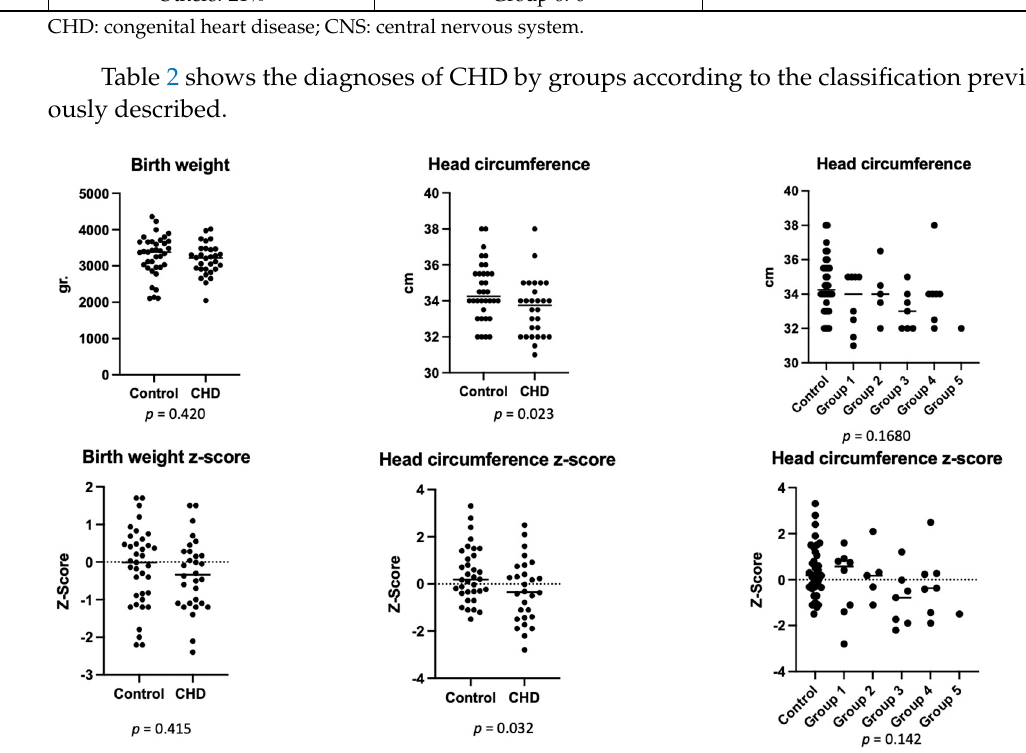
Table 3. Oxidative stress biomarkers in amniotic fluid.